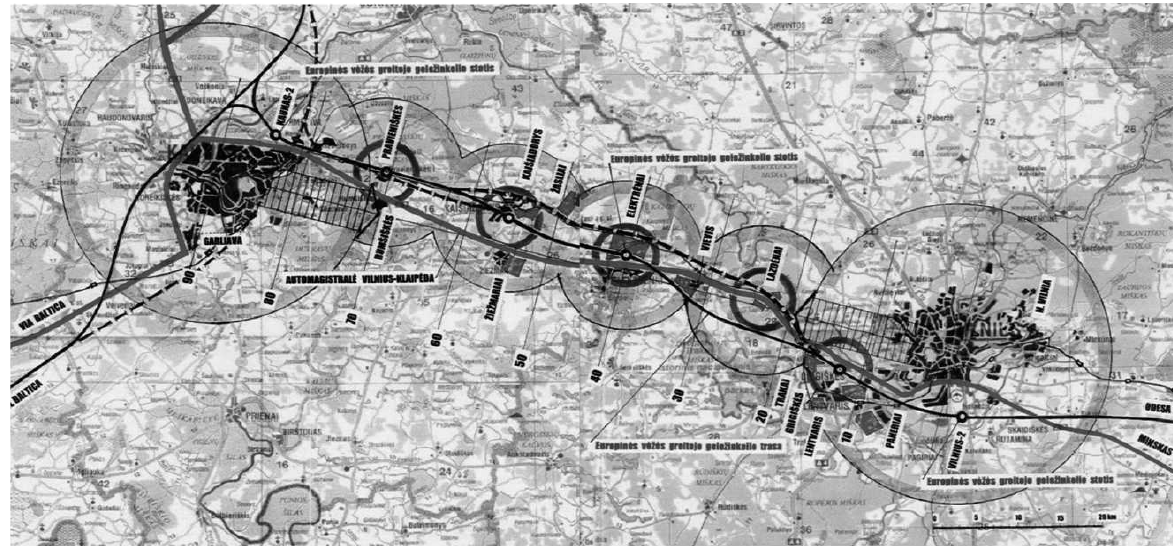
Fig 10. Urban conception scheme of Vilnius and Kaunas doublecity (according to Prof J.